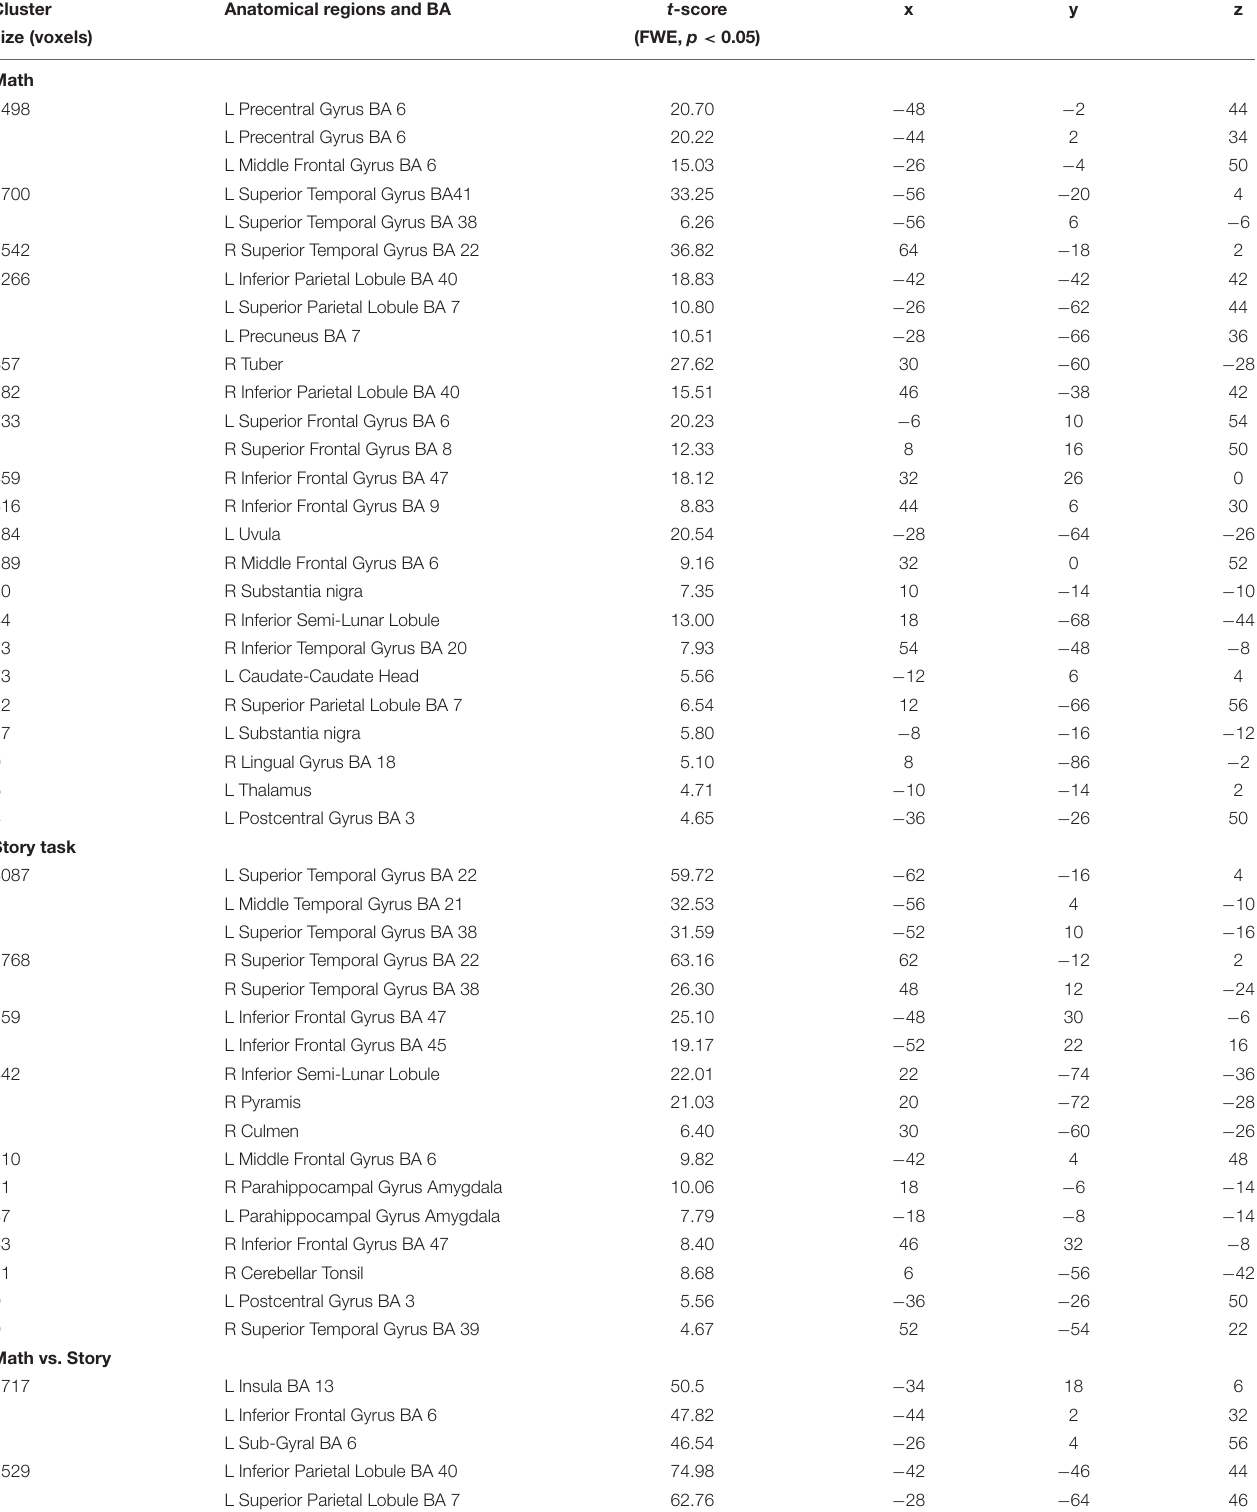
TABLE 1 | Activated regions during the two auditory stimuli and the different activated regions between them. Cluster Anatomical regions and BA t -score x